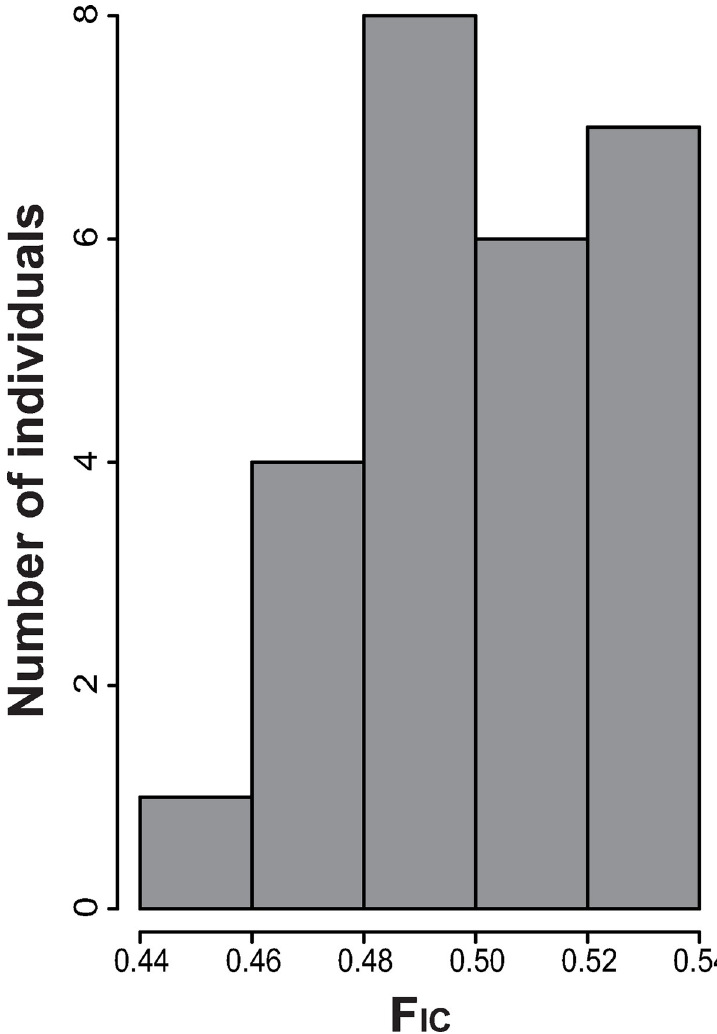
Fig 6. Inbreeding frequency distribution. Calculated for the 26 individuals of T . keyserlingii from the UAE.